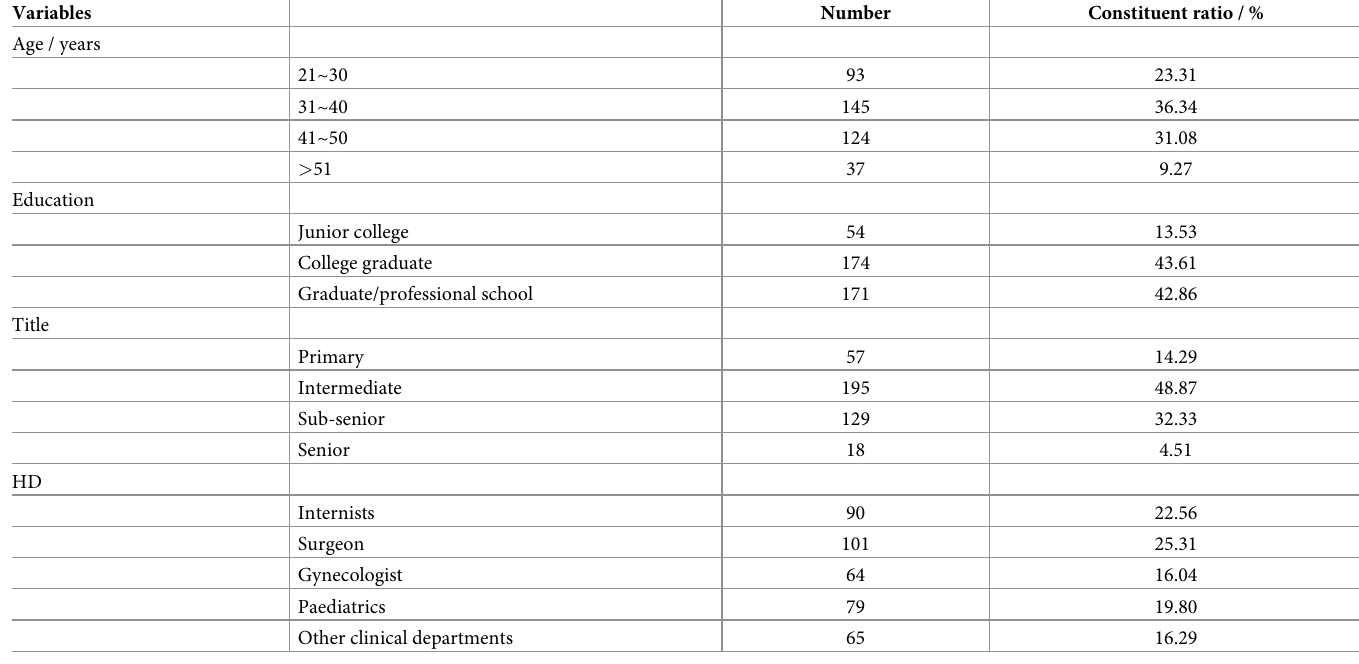
Table 1. Demographic characteristics of the